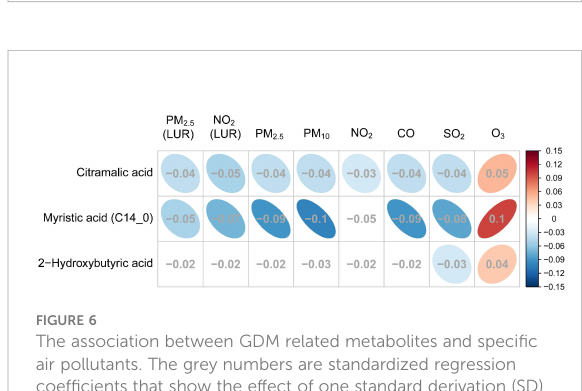
FIGURE 5 Odds ratios between air pollution exposures and GDM occurrence. Green indicates the unadjusted odds ratio (95% CI); blue indicates the adjusted odds ratio (95% CI). Hollow shapes represent statistical signi fi cance, while solid shapes are non-signi fi cant.